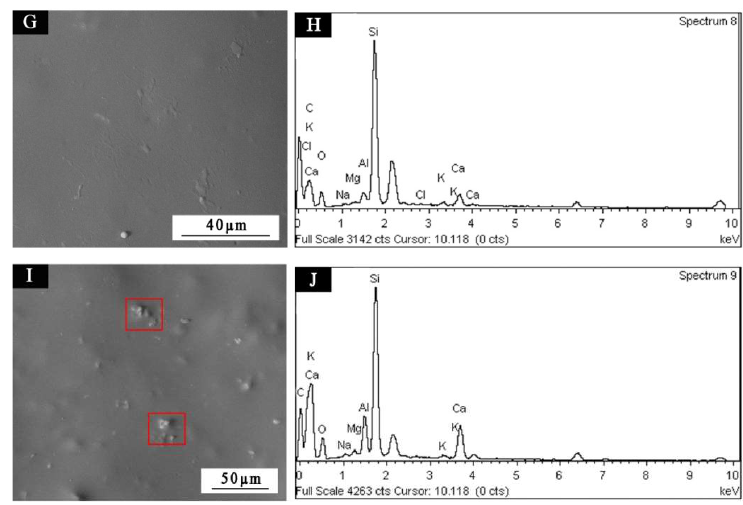
Figure 2. SEM images: ( A ) waterborne coating; waterborne coating with different concentrations of WSPALR: ( C ) 0.5% and ( E ) 5.0%; and waterborne coating with different concentrations of calcined WSPALR: ( G ) 0.5% and ( I ) 5.0%. EDX analysis: ( B ) waterborne coating; waterborne coating with different concentrations of WSPALR: ( D ) 0.5% and ( F ) 5.0%; and waterborne coating with different concentrations of calcined WSPALR: ( H ) 0.5% and ( J ) 5.0%. Table 2. Si concentration of waterborne coatings.